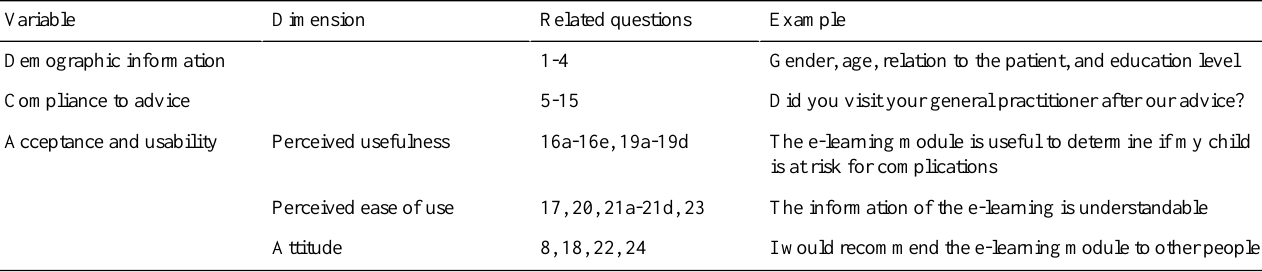
Table 1. Questions used to evaluate compliance, acceptance, and